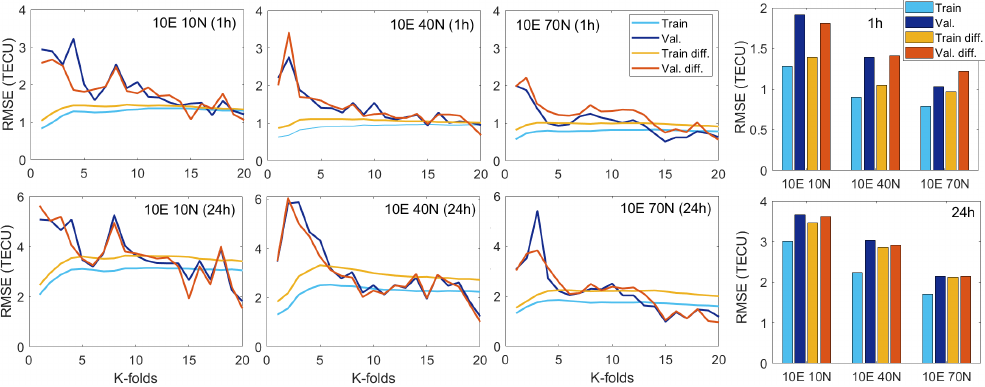
Figure 9. RMSE on training and validation data from 1st to 20th k-fold ( left ). The bar graph represents the average RMSE for all 20 k-folds ( right ). Top: 1-h, bottom: 24 h forecast. Results are provided for the model VR1 for both non-differenced and differenced (diff.)